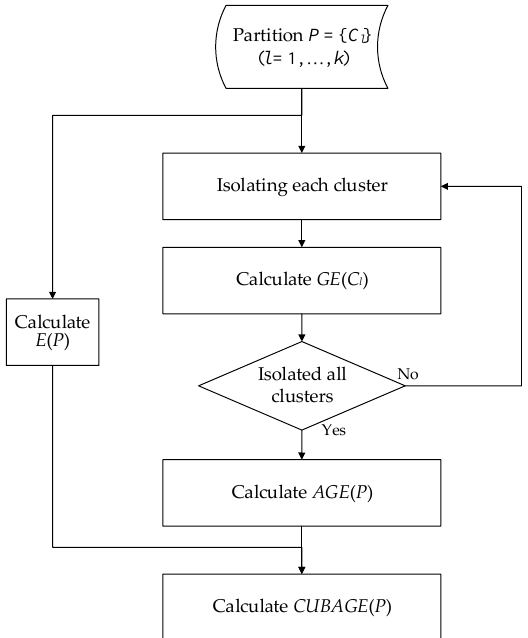
Figure 3. Flowchart of CUBAGE .